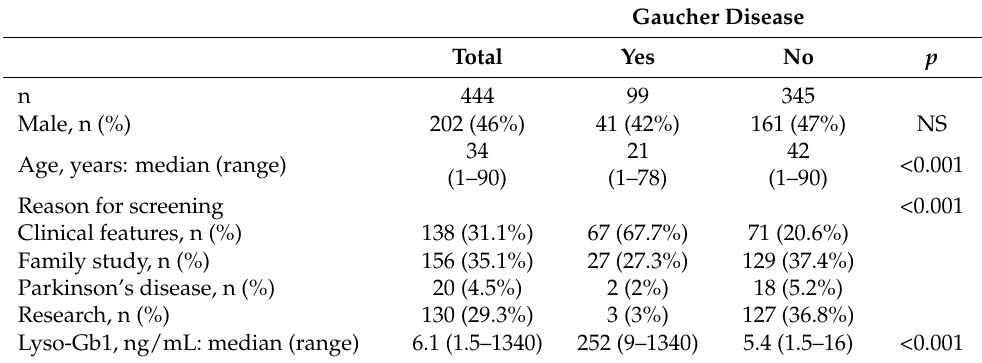
Table 1. Characteristics of subjects with and without a diagnosis of Gaucher